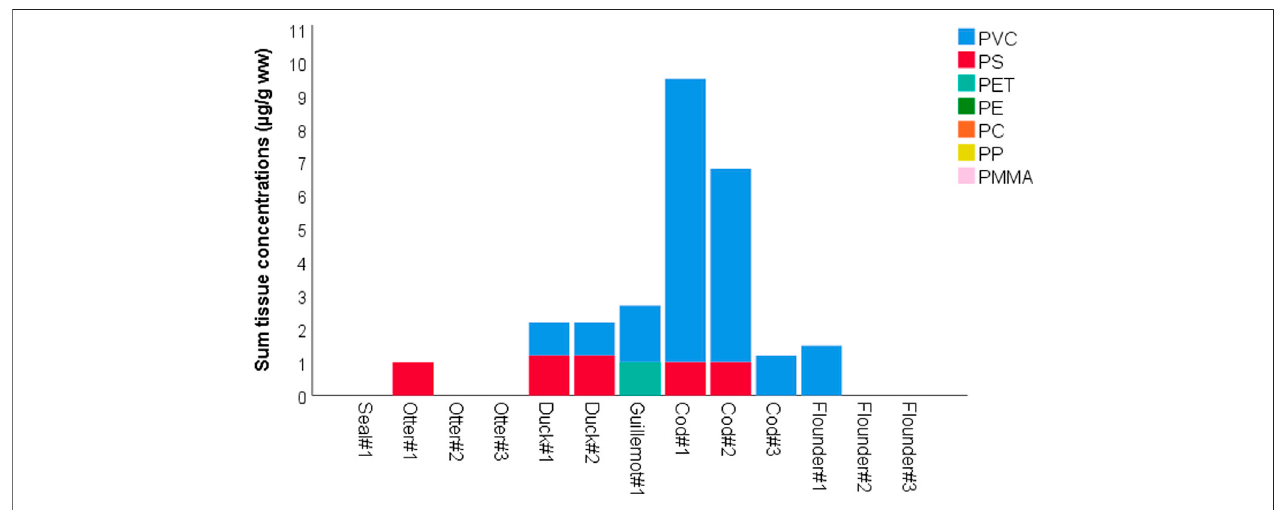
FIGURE 2 | Sum of tissue concentrations (µg/g ww) of detected microplastic polymer types in coastal animals from Sotra in 2018 – 2019.